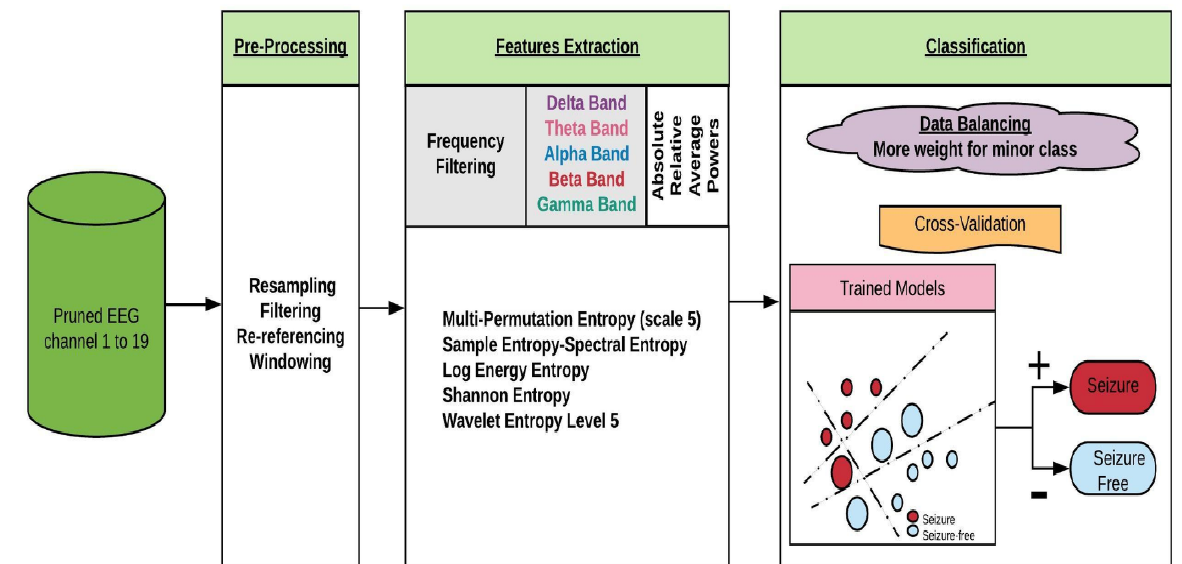
Figure 2. A block diagram of this study’s automatic seizure detection method. A total of 19 pruned EEG channels from the TUSZ corpus are resampled, filtered, re-referenced, and segmented. Features are subsequently extracted and used as input for modelling and testing four classifiers separately (RF, GB, k-NN, and SVM).